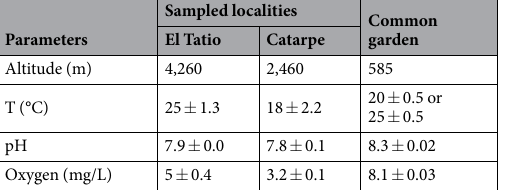
Table 2. Altitude and three physicochemical parameters of the water are indicated for the localities studied (El Tatio and Catarpe, Chile) and the common garden experiment. The values are shown as mean ± standard error, except for